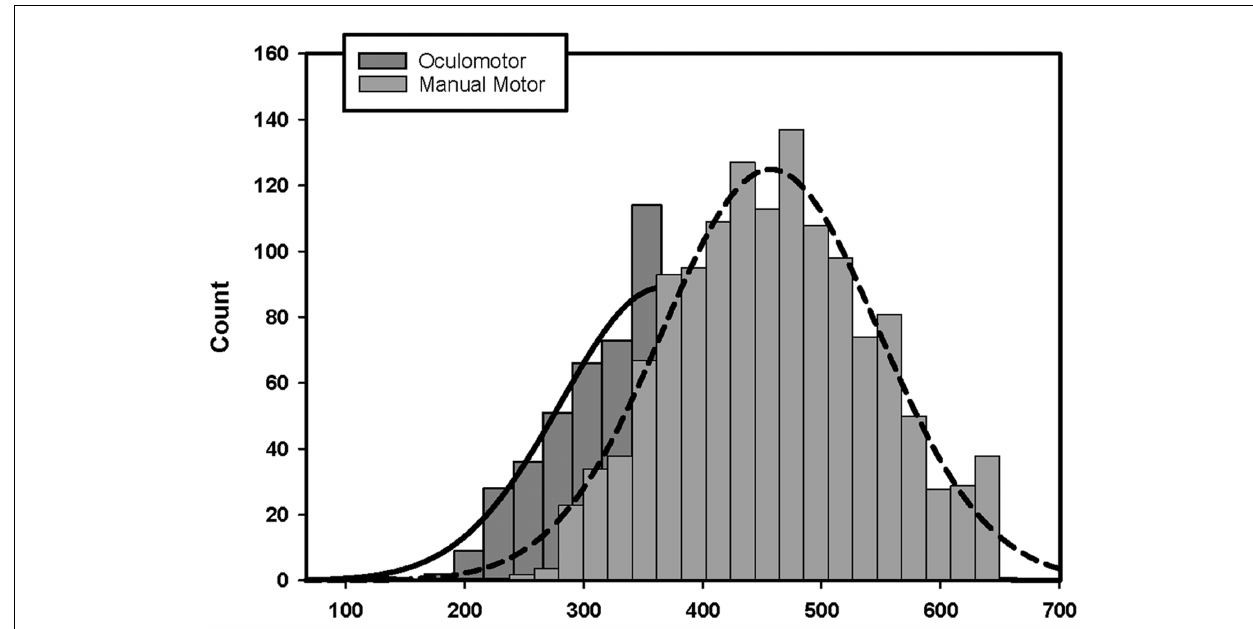
FIGURE 5 | Histogram of reaction time slowing on GO trials following STOP trials. Manual motor reaction times were slowed to a greater degree compared to oculomotor reaction times on GO trials when preceded by STOP trials.